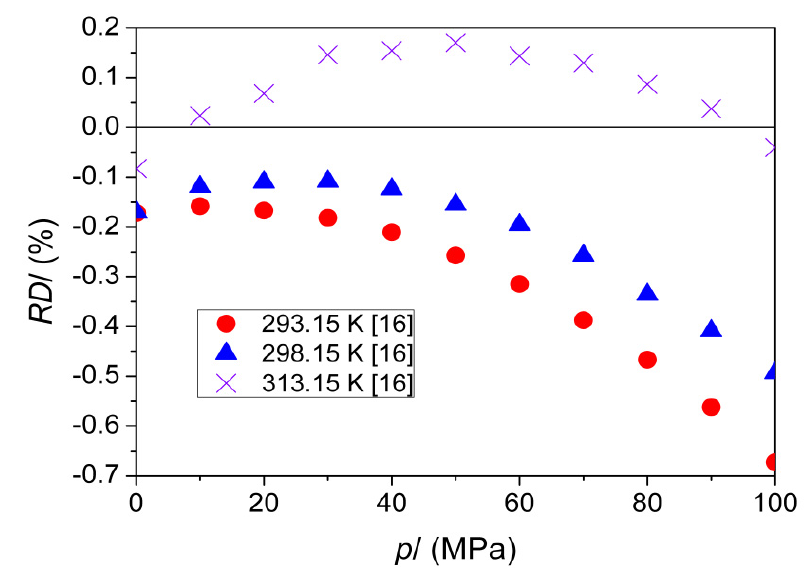
Figure 5. Comparison of the isobaric heat capacity of 1-butanol as a function of pressure obtained in this work ( C p , this work ) with the literature values ( C p , lit ) [16] presented as relative deviations RD s ( RD /% = 100 · ( C p , this work − C p , lit ) / C p , this work ).